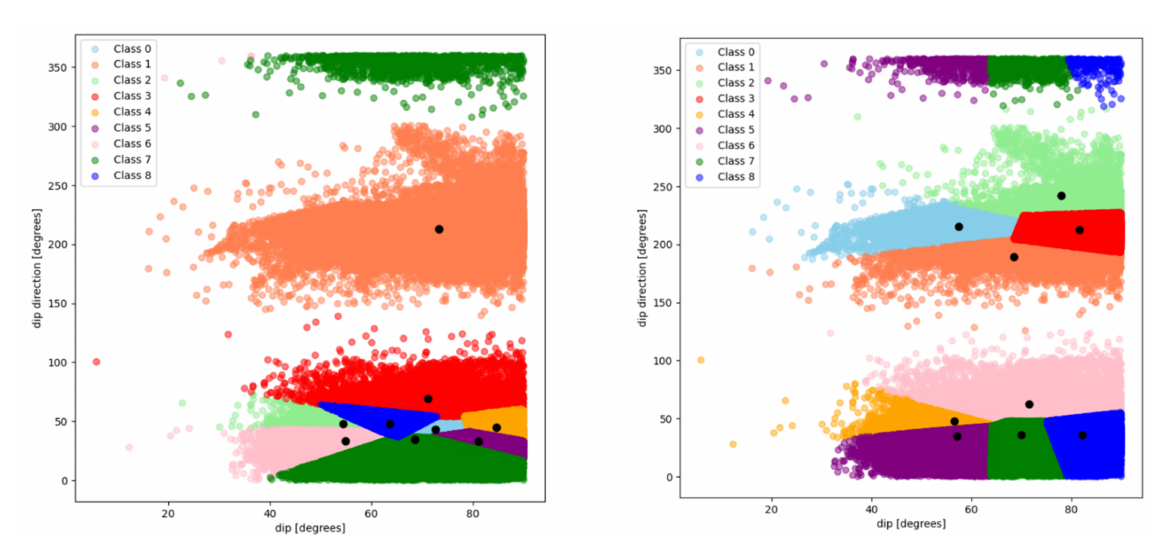
Figure A1. ( Left ): example of classification using automatic initialization of centroids with 9 classes. ( Right ): example of classification using manual initialization of centroids with 9